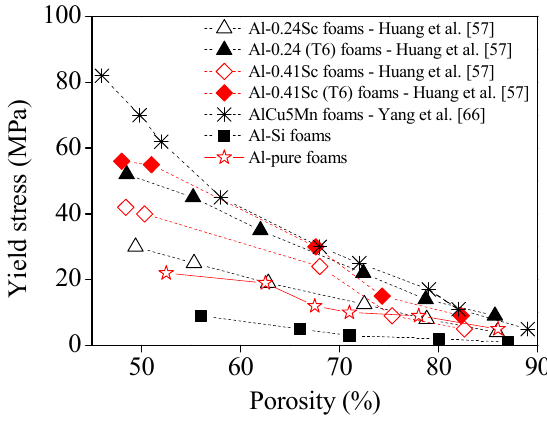
Figure 4. Comparison of different Al-based foams [57,66].